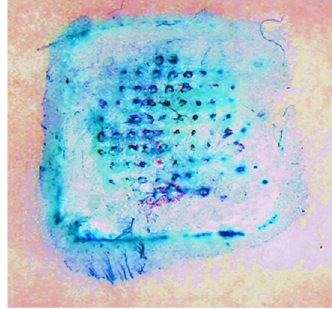
Figure 3. Observation of pores formed by Zika vaccine MPs-loaded dissolving MNs in the murine skin using methylene blue